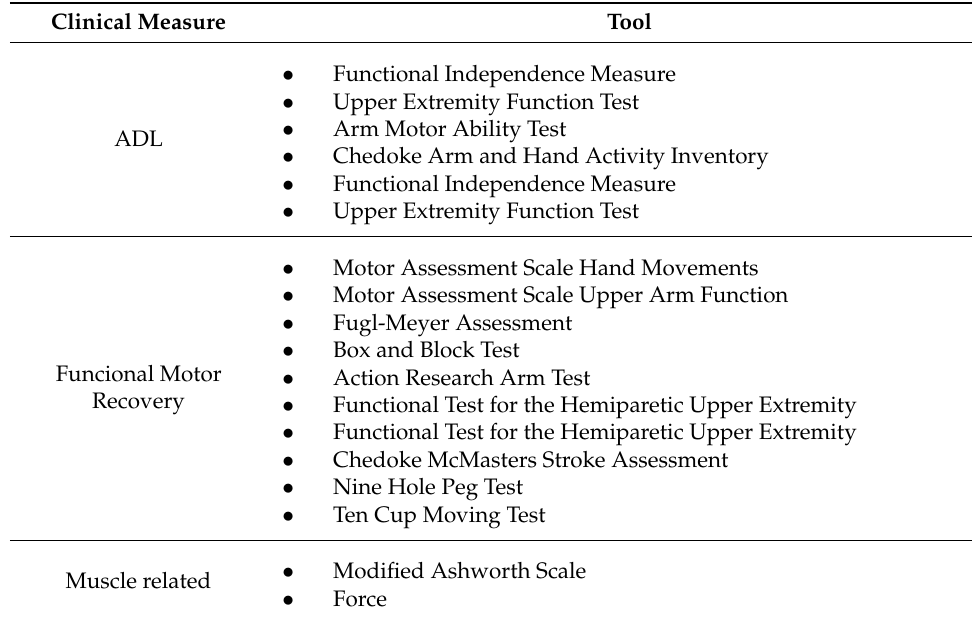
Table 1. Clinical measures used to assess FES